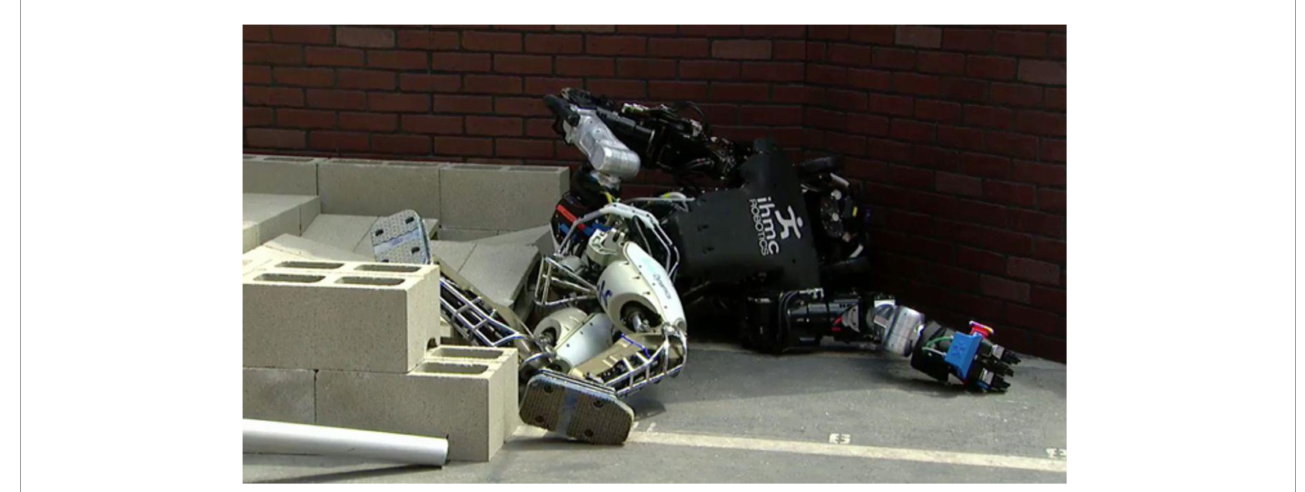
FIGURE1 IHMC’s Atlas was one of the robots that fell during the DARPA robotics challenge finals. Source: DARPA (Guizzoevan and Ackerman,